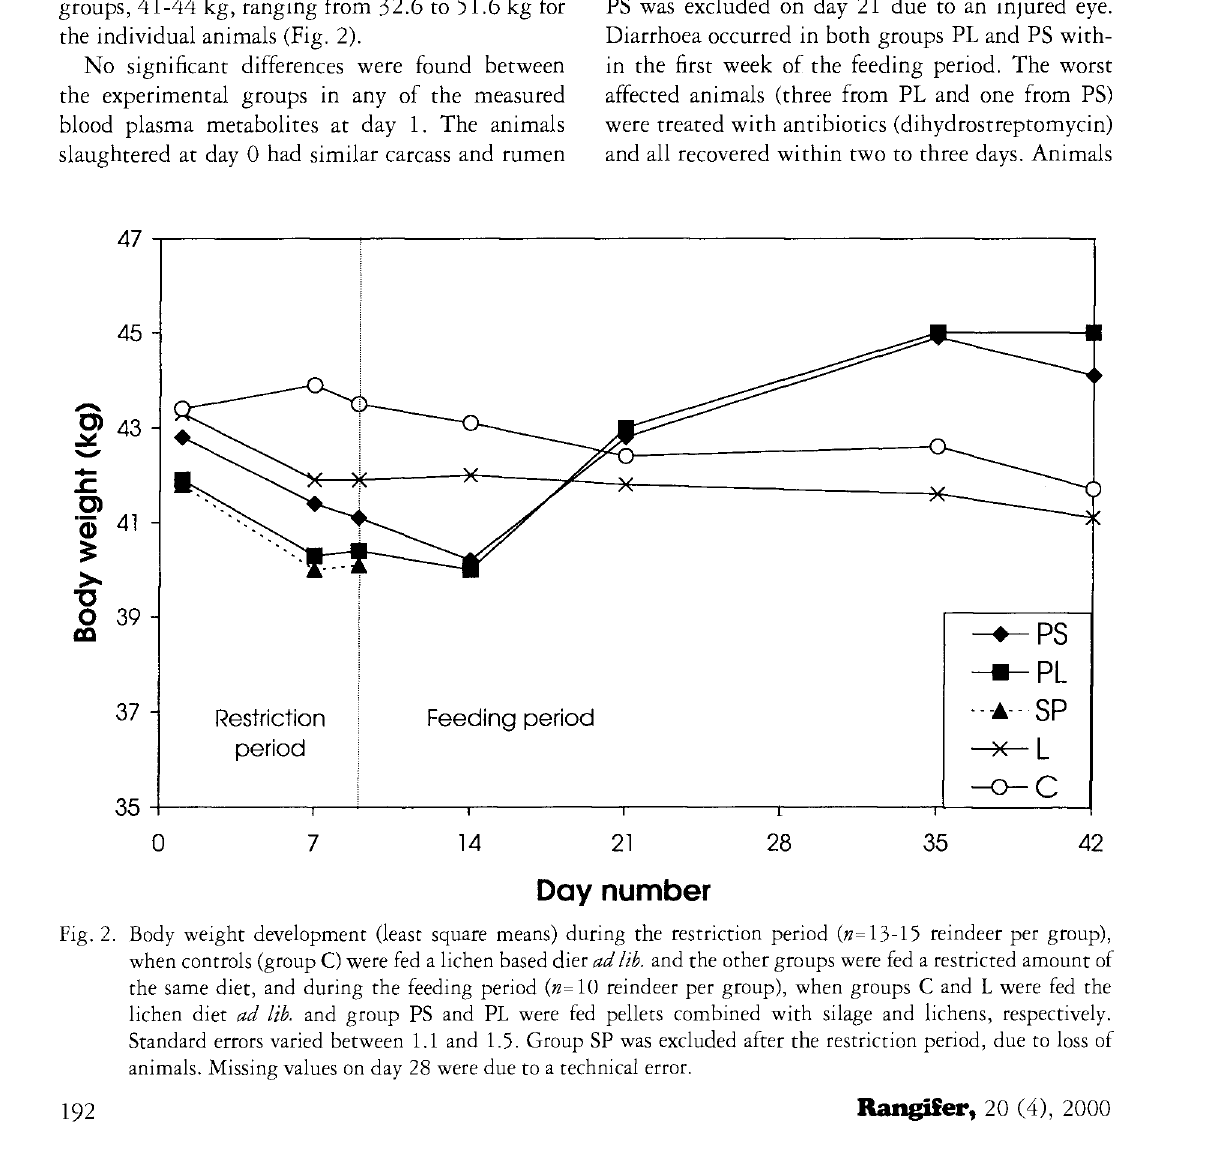
Fig. 2. Body weight development (least square means) during the restriction period («=13-15 reindeer per group), when controls (group C) were fed a lichen based dier ad lib. and the other groups were fed a restricted amount of the same diet, and during the feeding period («=10 reindeer per group), when groups C and L were fed the lichen diet ad lib. and group PS and PL were fed pellets combined with silage and lichens, respectively. Standard errors varied between 1.1 and 1.5. Group SP was excluded after the restriction period, due to loss of animals. Missing values on day 28 were due to a technical